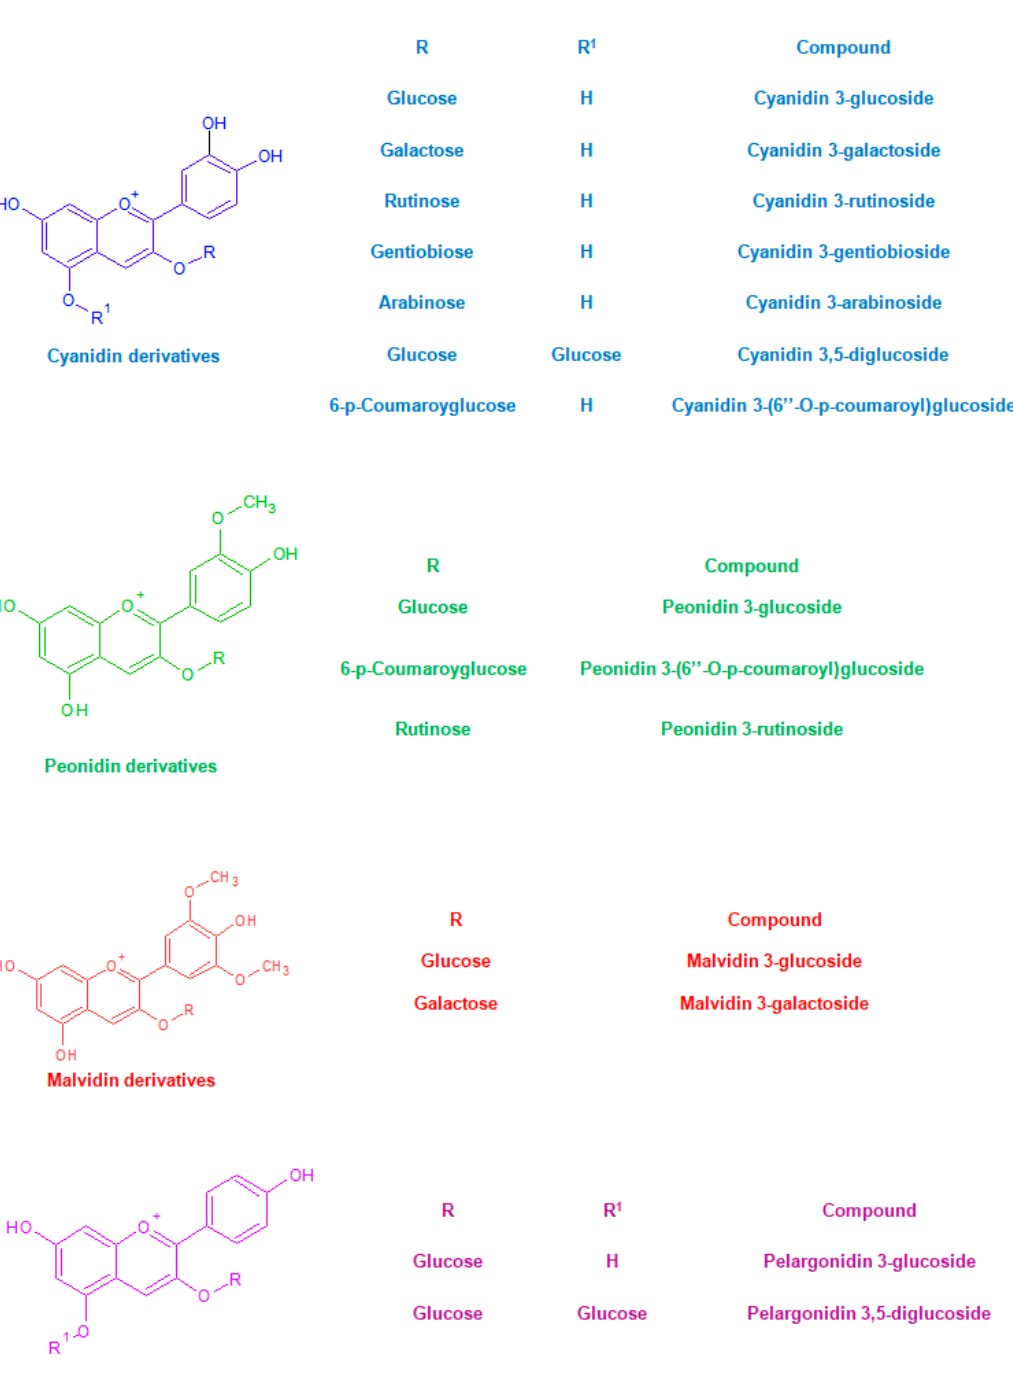
Figure 3. Some common anthocyanins detected in rice [2].